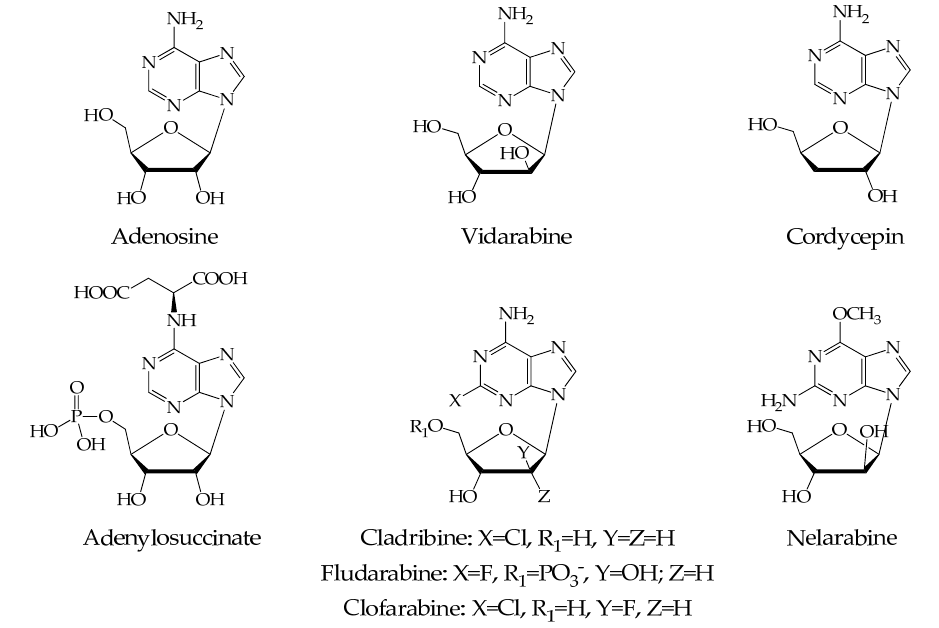
Figure 1. Biologically active purine nucleosides.